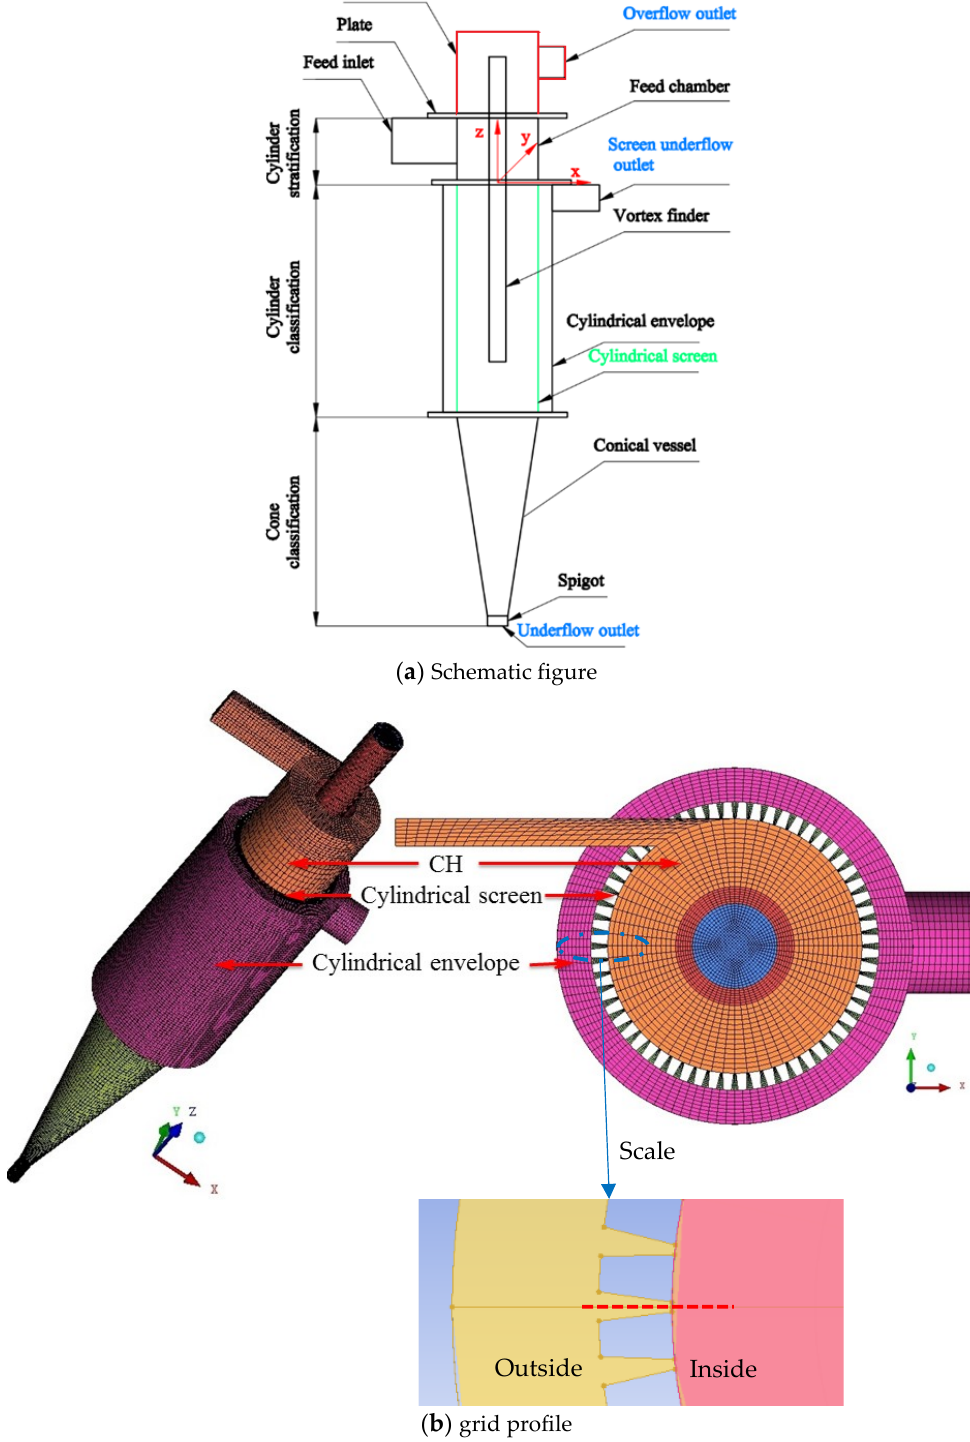
Figure 1. Diagram of 75 mm three products hydrocyclone screen (TPHS).